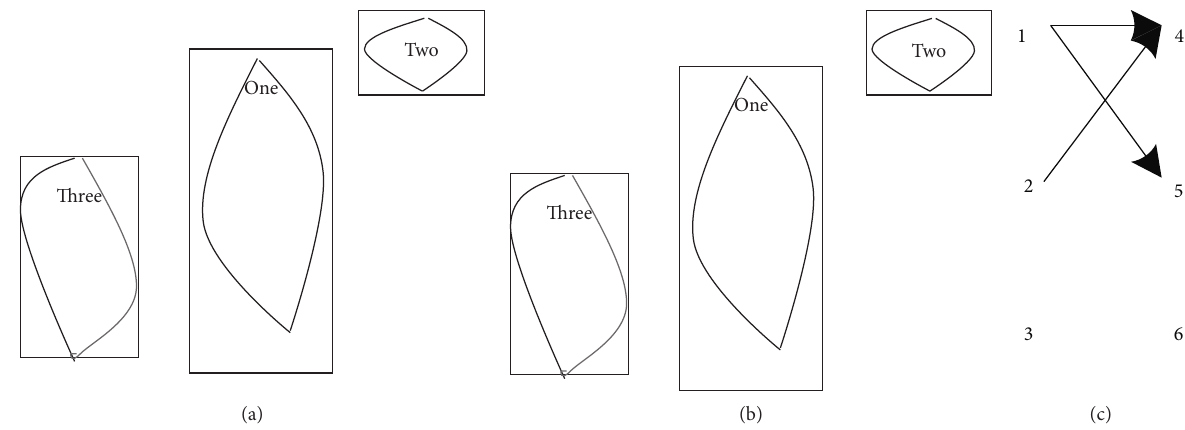
Figure 3: Four kinds of transformation in the region. (a) The area in frame k − 1. (b). The area in frame K (c). Correspondence between regions.